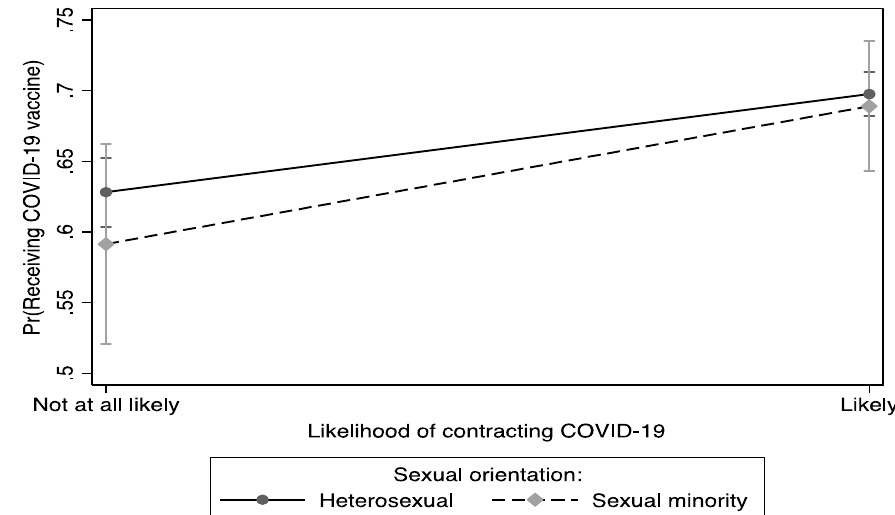
Figure 2. Differences in the perceived likelihood of receiving the COVID-19 vaccine between and within sexual orientation and self-reported likelihood of contracting COVID-19.